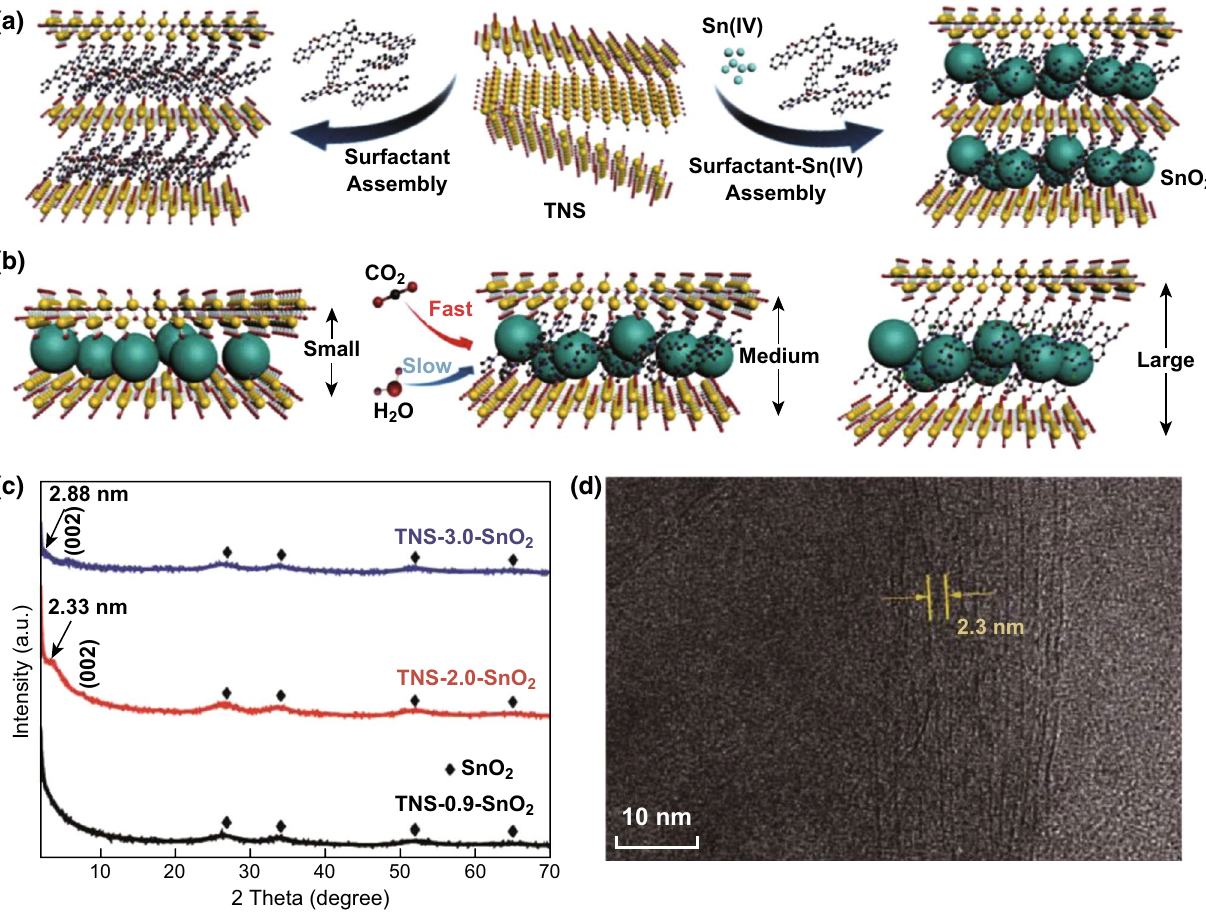
Fig. 8 a Schematic illustration of the surfactant‑induced 2D assembly of confined space with TNS and SnO 2 nanoparticles. b Schematic illus‑ tration of 2D TNS‑SnO 2 assembly with different interlayer spacings for electrocatalytic CO 2 reduction. c XRD patterns of TNS‑0.9‑SnO 2 , TNS‑ 2.0‑SnO 2 , and TNS‑3.0‑SnO 2 . d HRTEM of TNS‑2.0‑SnO 2 . Reprinted with permission from Ref.